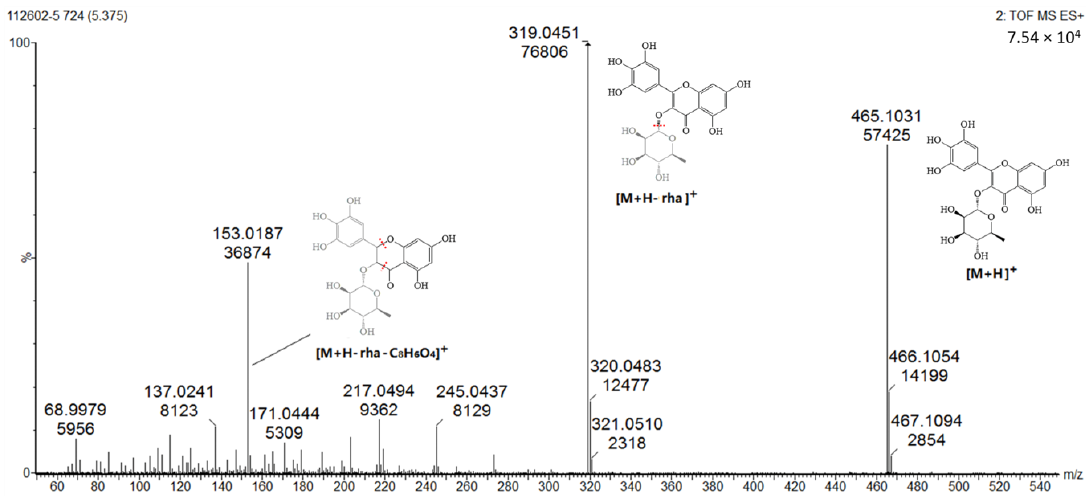
Figure 4. Product ion spectrum and proposed MS fragmentation mechanism of peak 5 in positive mode.